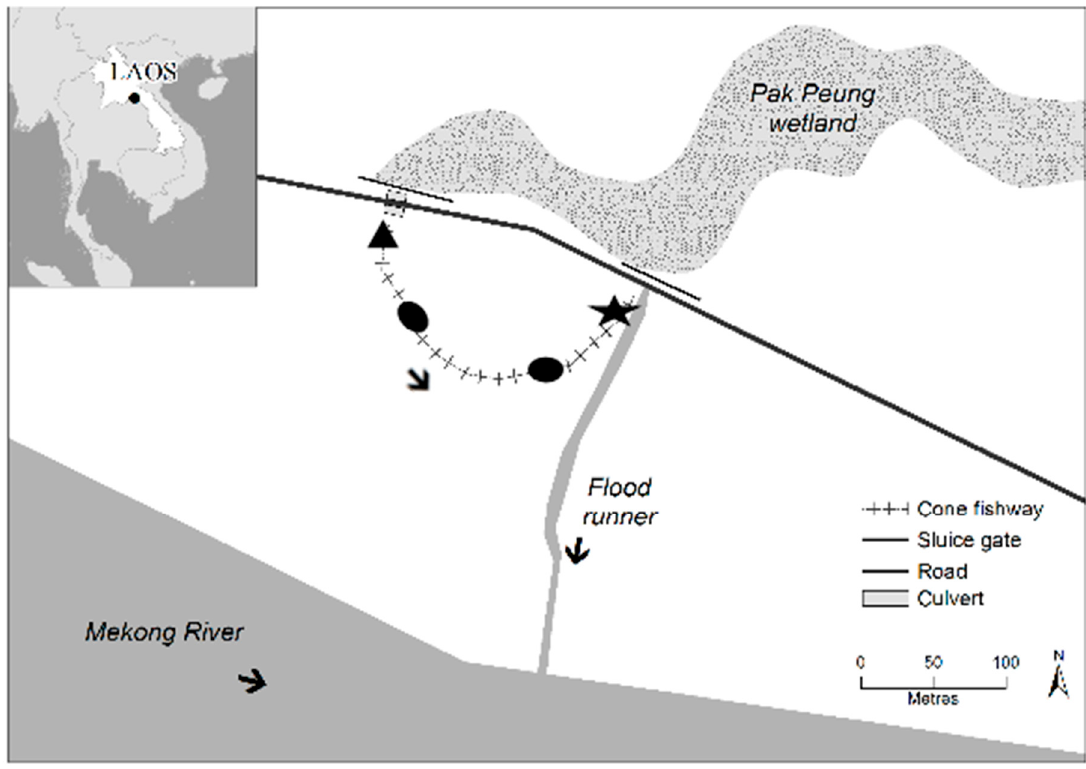
Figure 1. Site map of Pak Peung fishway (103.696943 ◦ E, 18.348375 ◦ N), in addition to a broader scale map of South East Asia displaying the location of the fishway within Lao PDR. Fish were sampled at the entrance (black star) and exit (black triangle) of the cone fishway (i.e., immediately downstream of the culvert). The arrows indicate the direction of flow in the fishway, flood runner and Mekong River. The black ovals on the fishway represent the long resting pools (source: Charles Sturt University GIS team using ARC GIS).